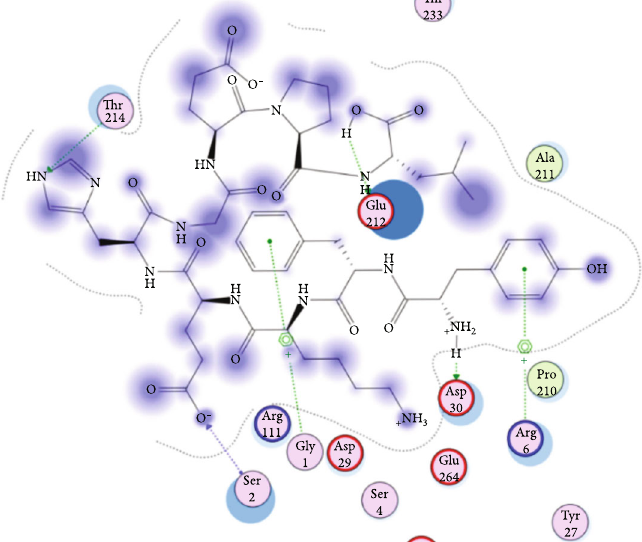
Figure 18: Illustration of the 3D interaction of the best docking poses of YFKEHGEPL in the binding sites of HLA-A ∗